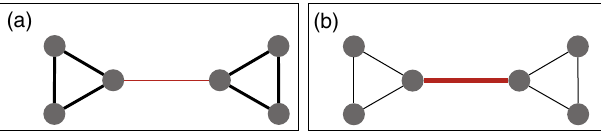
FIG. 6. (a) Illustration of the strength of social ties defined by Eq. (2). (b) Illustration of viral transmissibilities for negative η defined by Eq. (3).